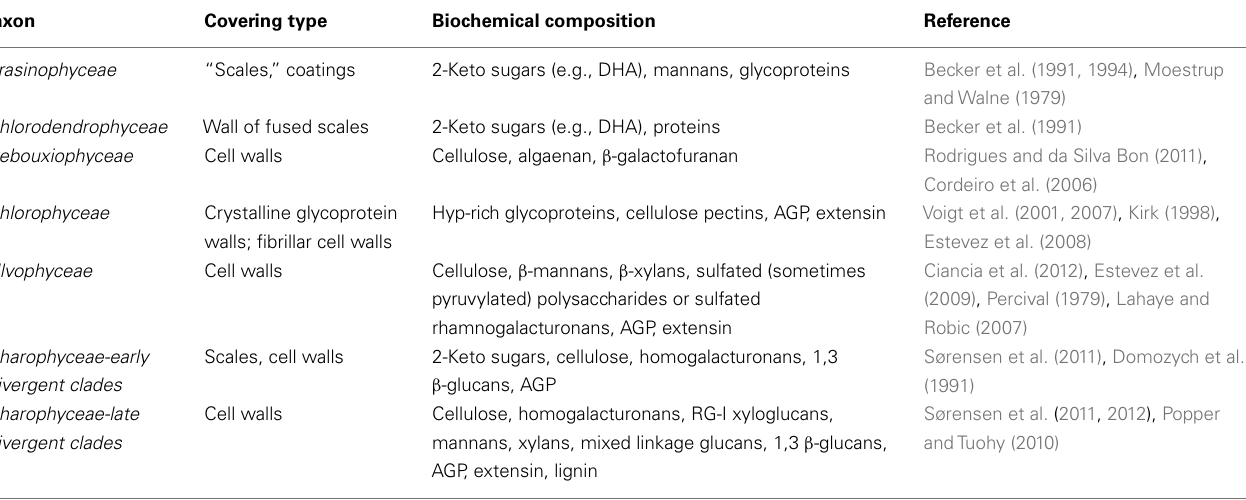
Table 2 | Summary of the composition of extracellular coverings in green